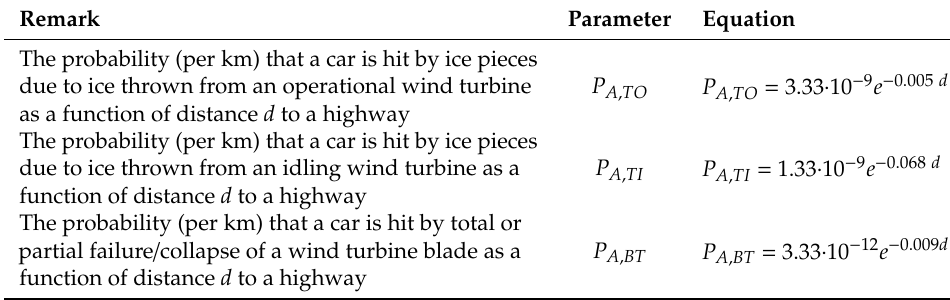
Table 1. Summary of probability (per km) that a car will be hit by ice or blade thrown